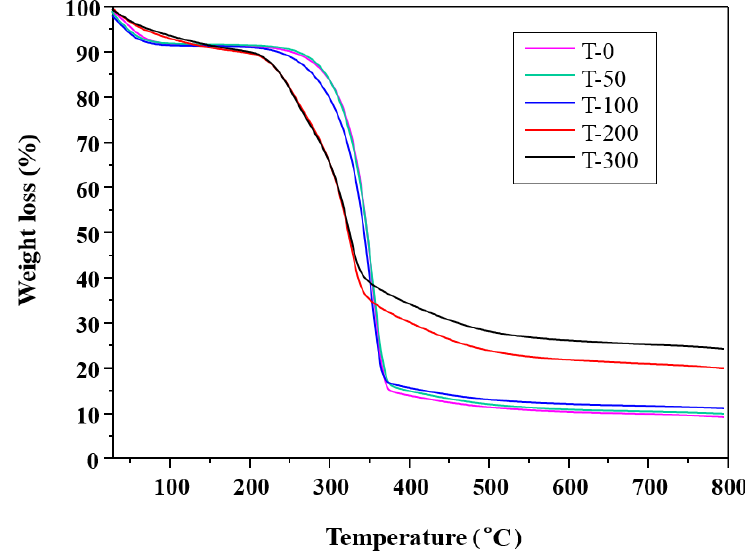
Figure 6. Thermogravimetric analysis results showing different thermal stability for P-0, P-50, P-100, P-200, and P-300.